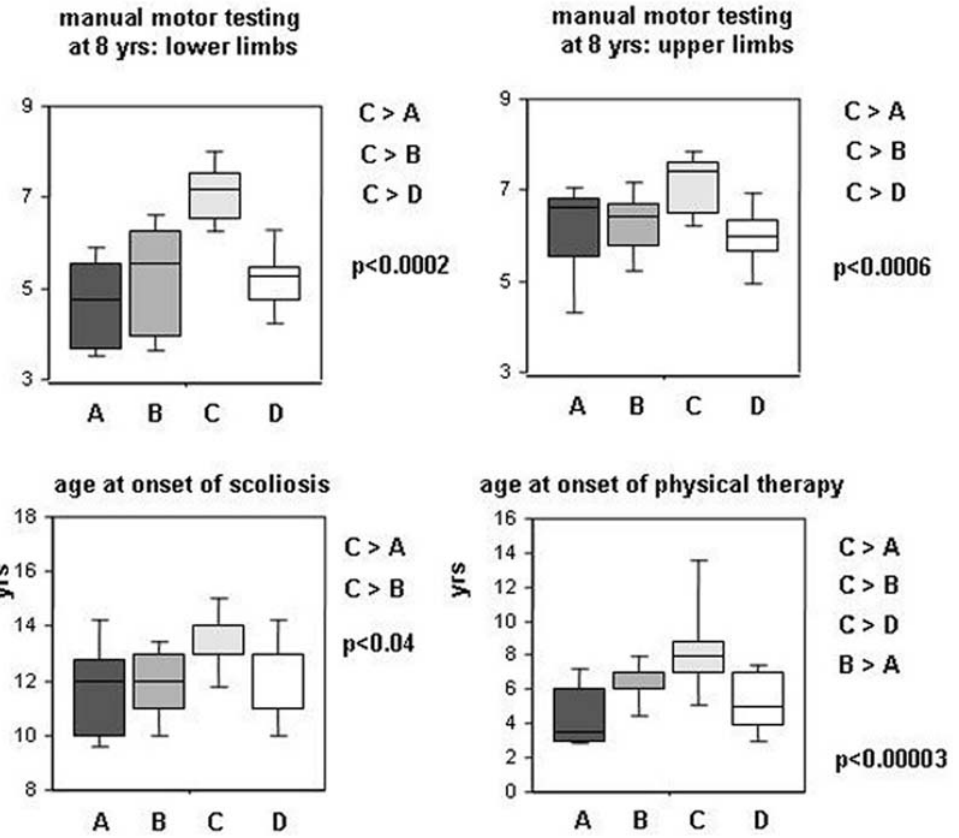
Figure 3. Muscle strength variables not used to constitute the model. C patients had better muscle strength than A, B, or D patients and a retarded onset of scoliosis. These motor parameters, not used in the multivariate analysis, support the validity of the model. ‘‘Age at onset of physical therapy’’ trailed behind the evolution of muscle strength and motor function: no clear benefit from therapy could be demonstrated in this series (indicated p values are obtained by Kruskal-Wallis test; clusters were compared by a multiple range post-test with p , 0.05).